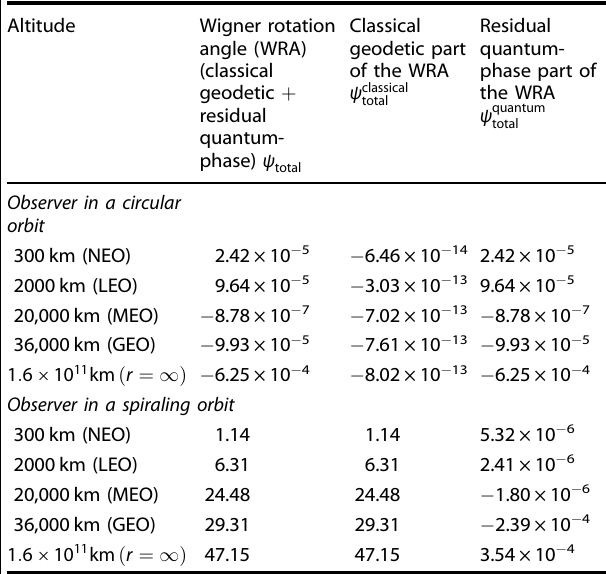
Table 1. Comparison of total integrated Wigner rotation angle (WRA) ψ , classical geodetic contribution to the WRA ψ classical total quantum-phase contribution to the WRA ~ ψ quantum satellite at various altitudes for two types of Earth orbits: (top) circular, (bottom) spiraling.